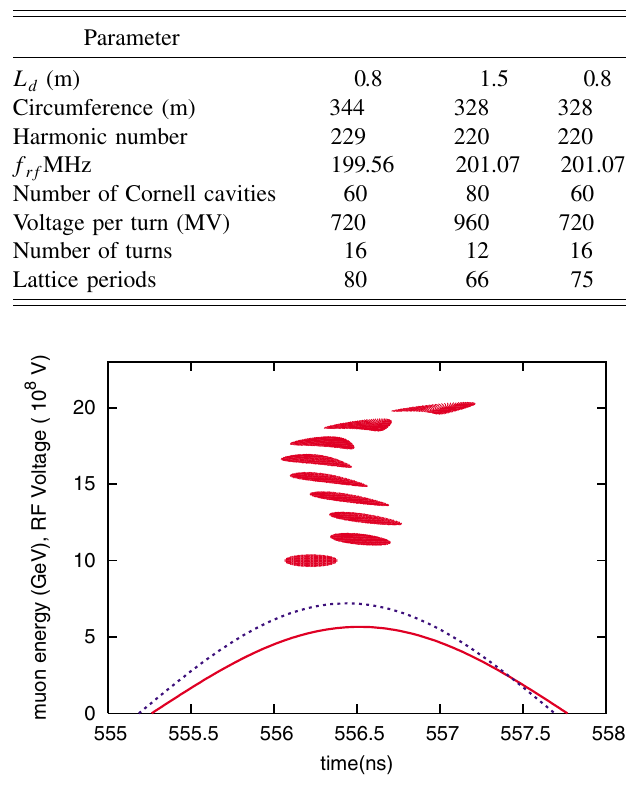
FIG. 20. (Color) Initial (dash) and final (full) rf voltage, and evolution of the bunch on turns 0 ; 2 ; . . . 16 , for L (cid:1) 344 m C 0